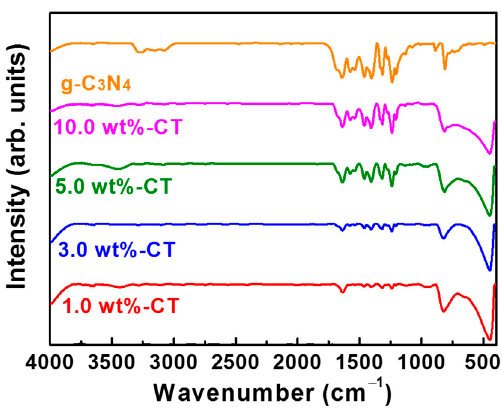
Figure 2. FTIR spectra of various g-C 3 N 4 /TiO 2 catalysts.